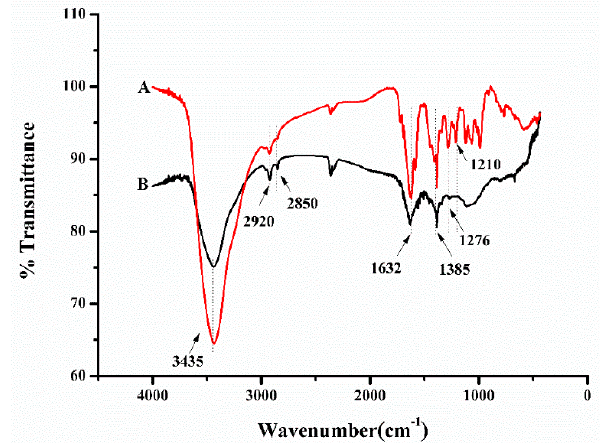
Figure 4. FT-IR spectra of ( A ) epirubicin and ( B ) epirubicin-capped silver NPs.